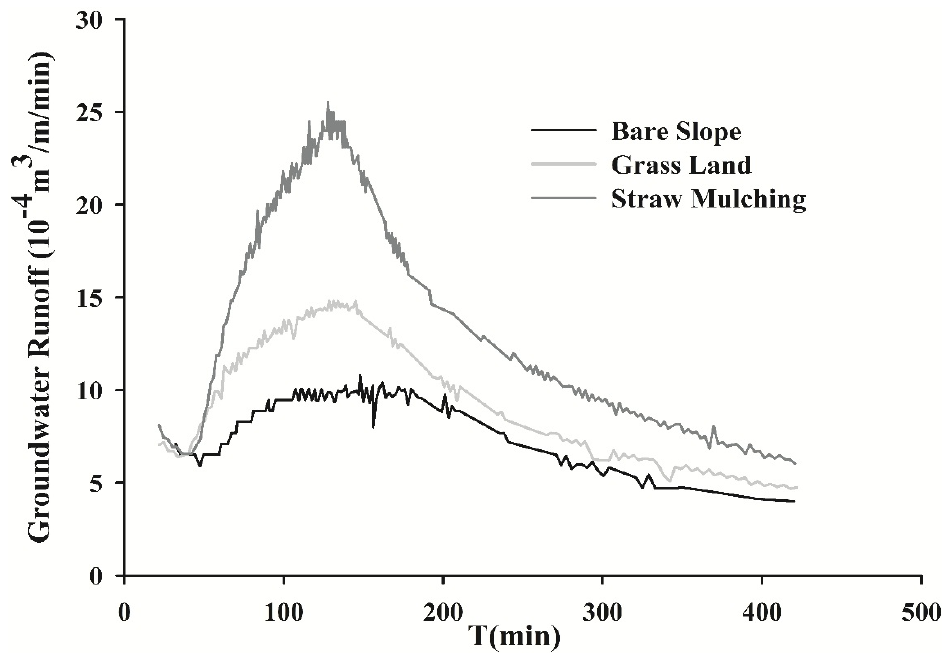
Figure 11. Time-series graphs of the groundwater runoff among three scenarios.